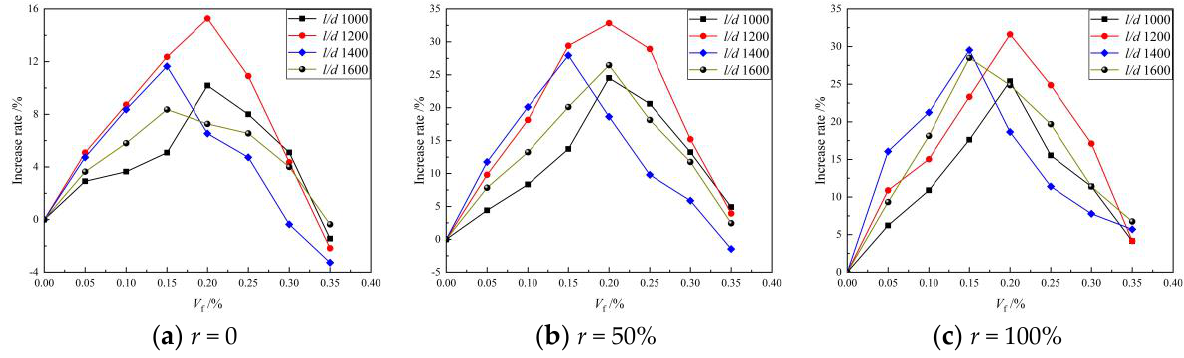
Figure 7. Relationship between BFRC splitting tensile strength and BF volume